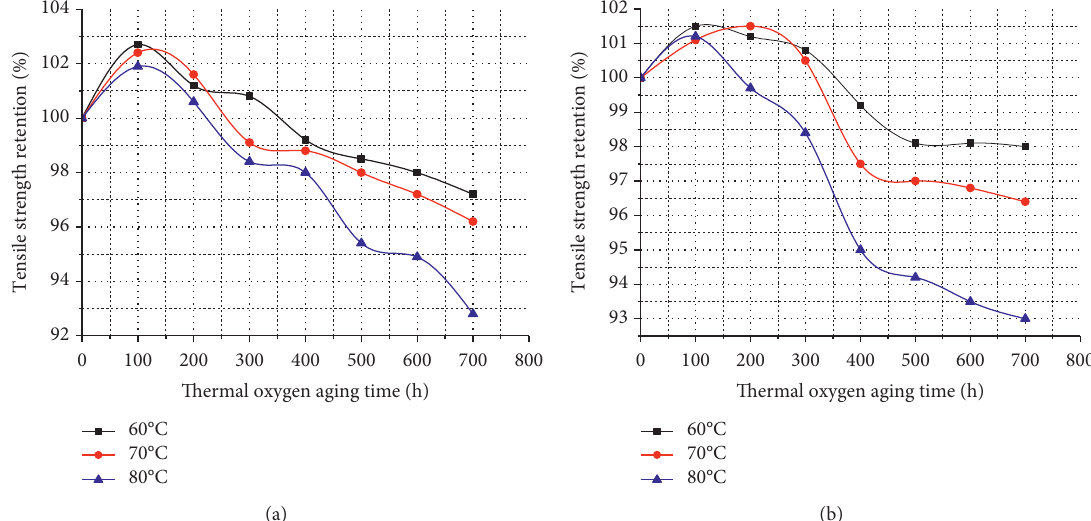
Figure 4: Relationship curves of tensile strength retention rate-thermal aging time. (a) BG1. (b) BG2.